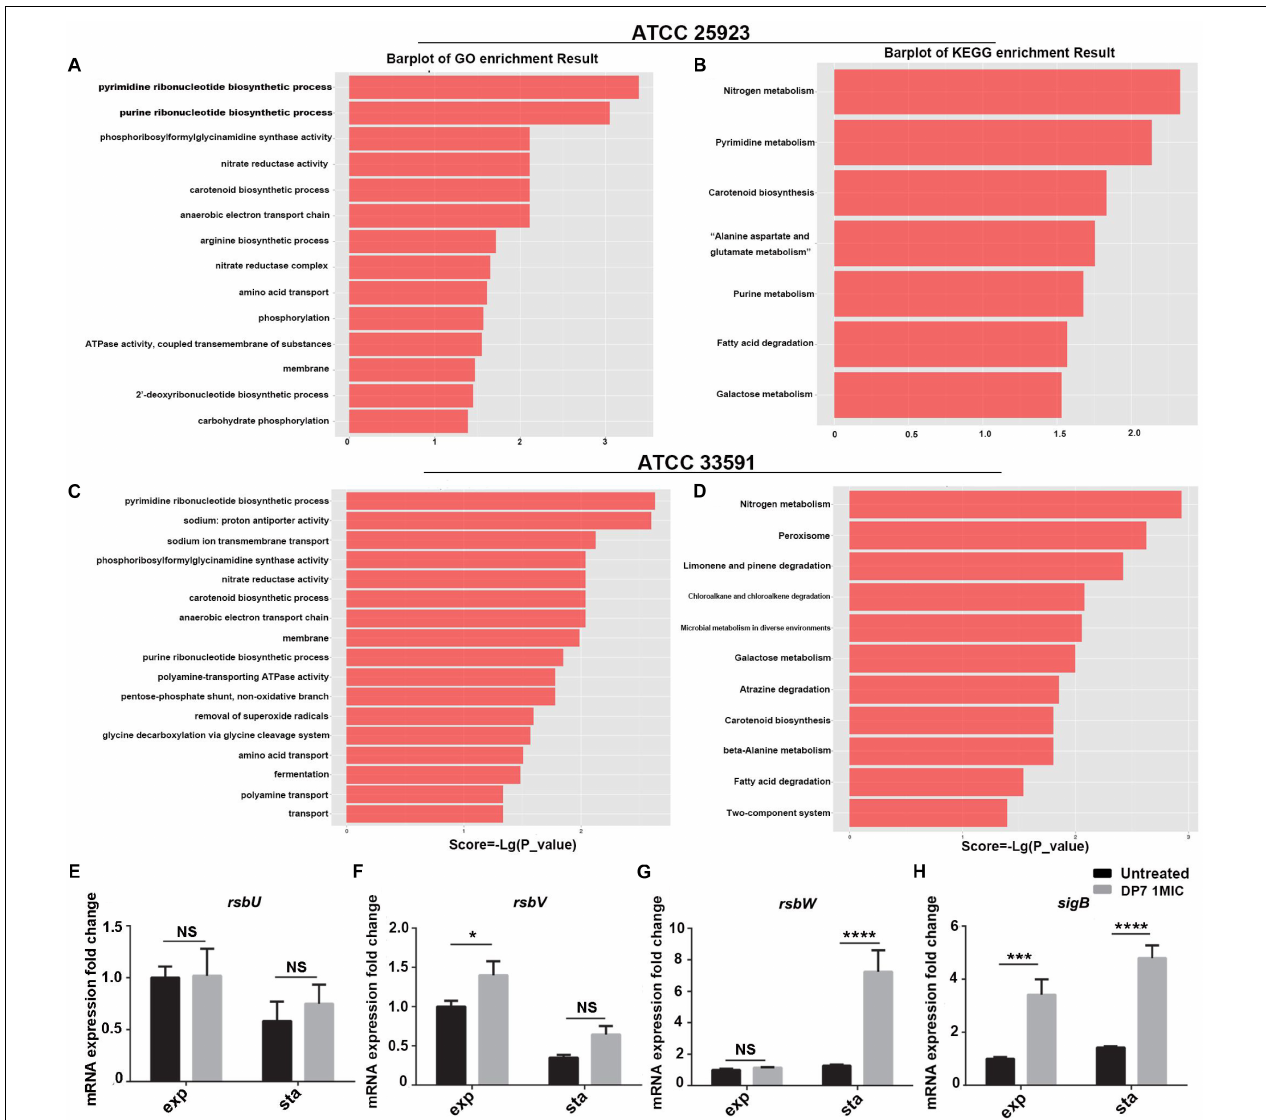
FIGURE 4 | Correlation pathway enrichment of differentially expressed genes after DP7 (1 × MIC) treatment of S. aureus ATCC 25923 and ATCC 33591. (A) GO term enrichment results of DP7-treated ATCC 25923. (B) KEGG term enrichment results of DP7-treated ATCC 25923. (C) GO term enrichment results of DP7-treated ATCC 33591. (D) KEGG term enrichment results of DP7-treated ATCC 33591. (E–H) Expression of sigB -related genes in S. aureus ATCC 25923 (black bars), DP7 (16 mg/L)-treated S. aureus ATCC 25923 (gray bars) during exponential (exp) and stationary (sta) phases. Each single row in the heat map corresponds to a single gene. ( n ≥ 3; ∗ p < 0.05; ∗∗∗ p < 0.001; ∗∗∗∗ p <